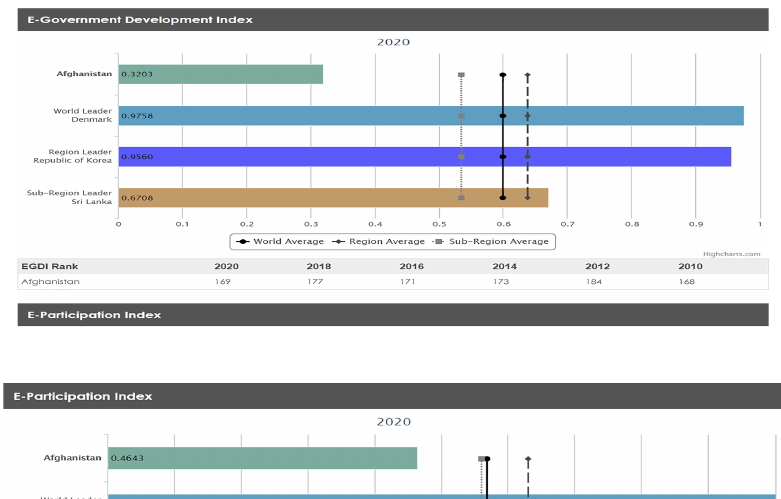
Figure 1. Afghanistan status in UN e-Government survey (2010, 2012,